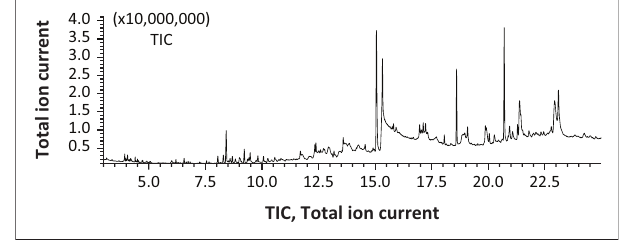
FIGURE 1: Gas chromatography–mass spectrometry chromatogram of Lantana trifolia methanolic extracts.